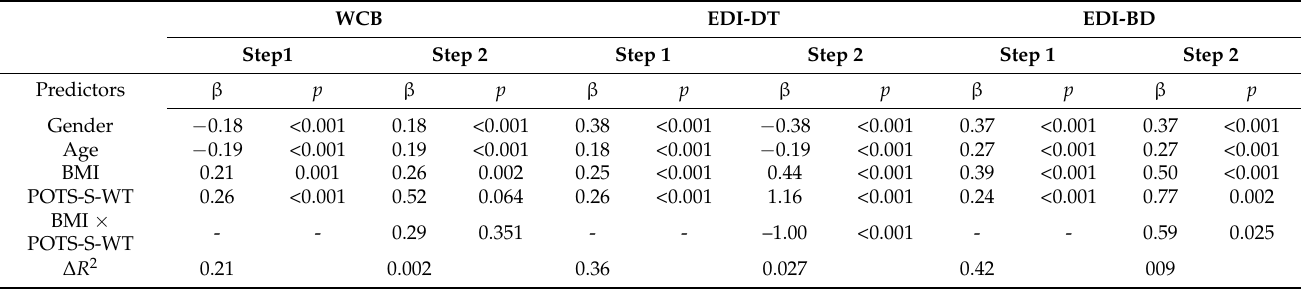
Table 4. Hierarchical regression analyses in the adult